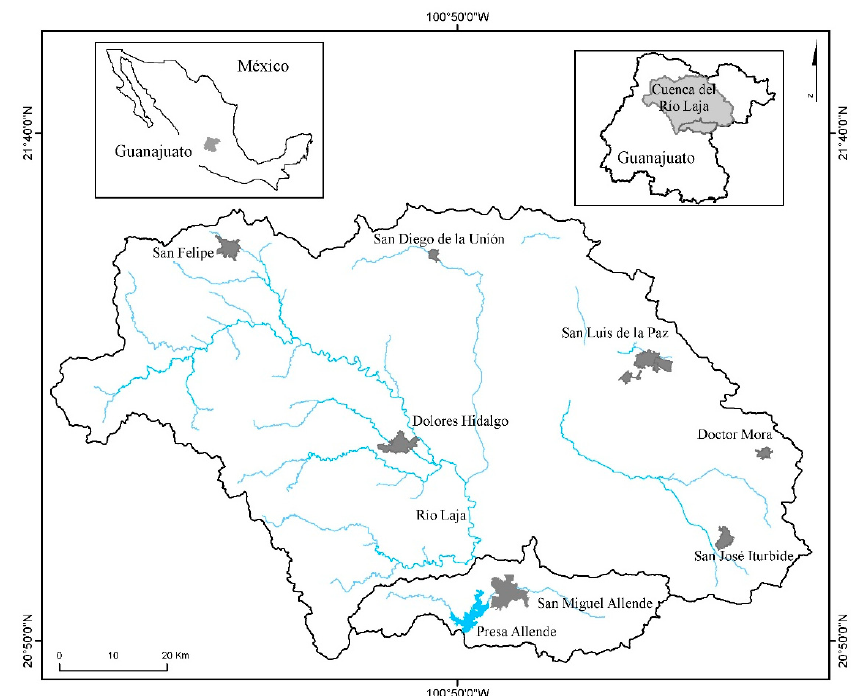
Figure 1. San Miguel de Allende in a national context, the state of Guanajuato, and the Río Laja river basin. Source: own construction (built by Oscar Salvatore, following [71]).